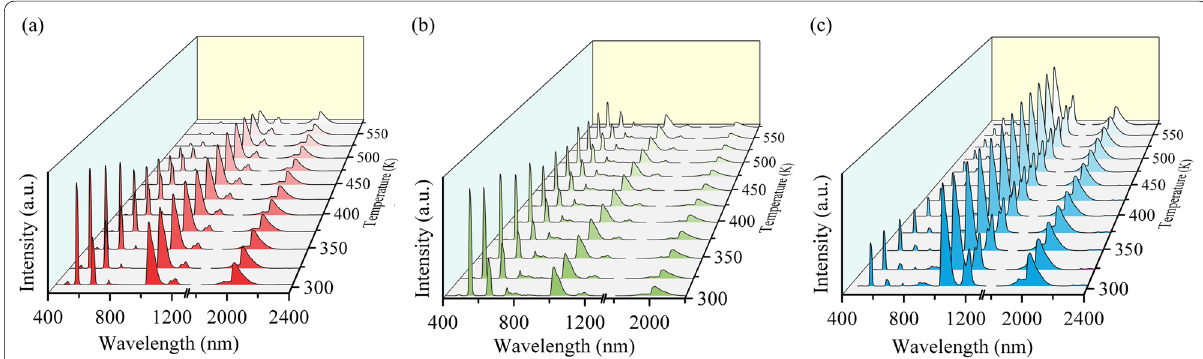
Fig. 6 Temperature-dependent spectra of SrF 2 :Yb 3 + /Ho 3 + (12/0.1 mol%) NCs under the a 980 nm, b 940 nm and c 915 nm excitations,